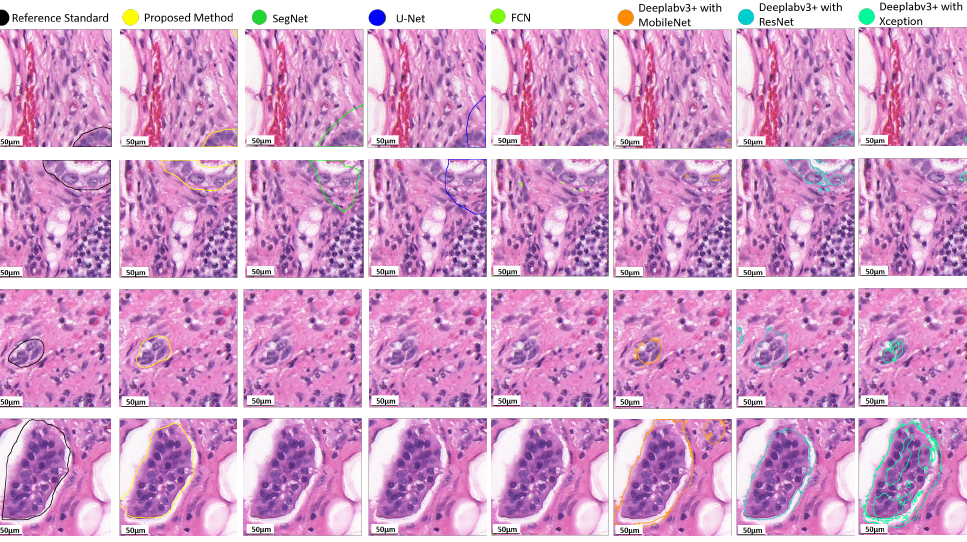
Figure 6. Qualitative evaluation of the metastasis segmentation results by the proposed method and the baseline approaches for breast cancer segmentation in histopathological